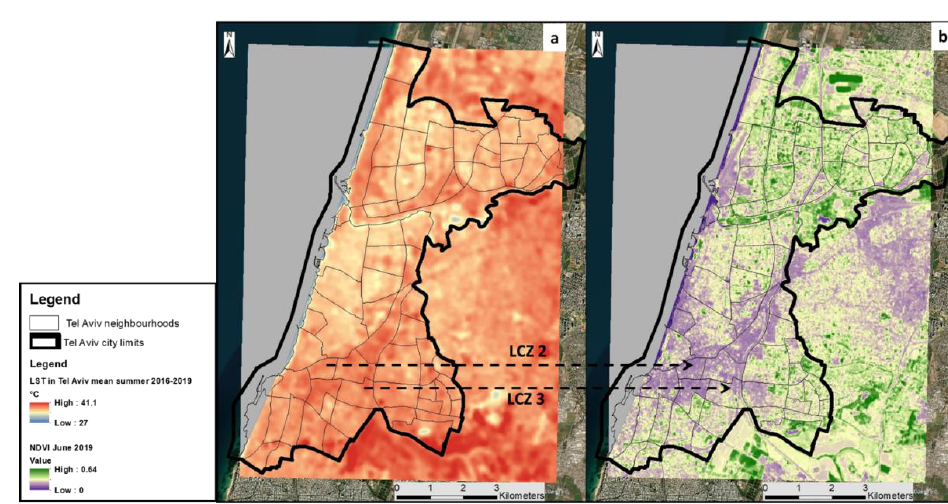
Figure 3. Landsat 8 images: ( a ) A mean land surface temperature (LST) summer 2016–2019 (June–August) map and ( b ) A mean normalized difference vegetation index (NDVI) from June 2019.